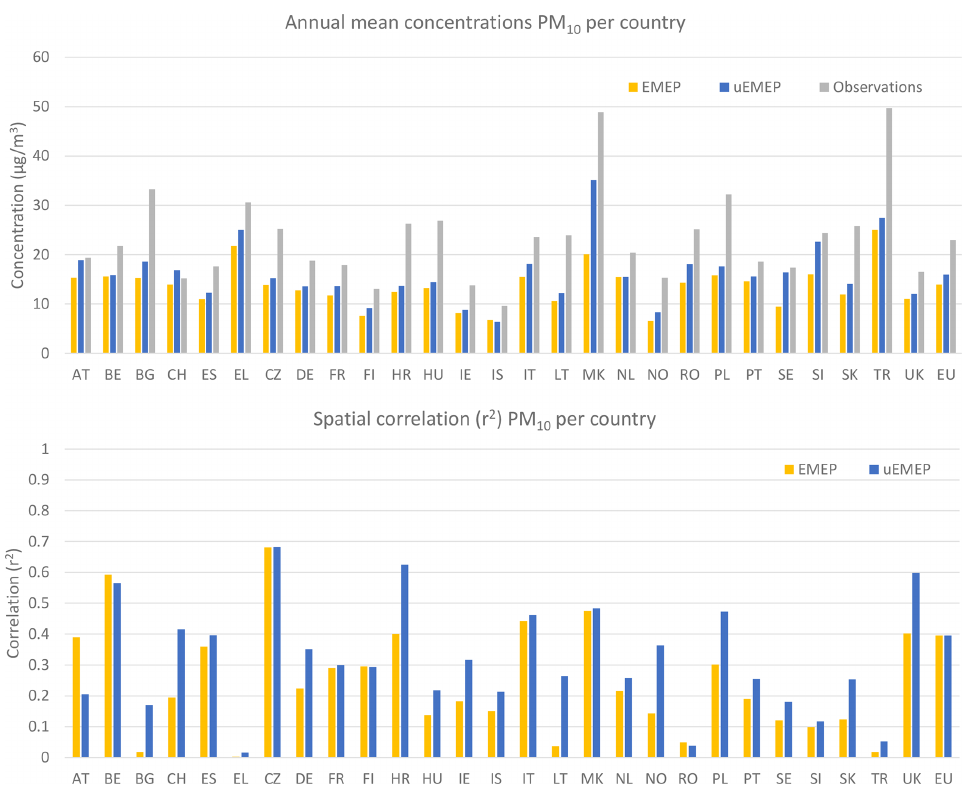
Figure 9. Annual mean PM 10 concentrations and spatial correlation (coefficient of determination r 2 ) per country for 2018 calculated with the EMEP model and uEMEP compared to AIRBASE observations including all types of stations. Only countries with 10 or more stations are shown, but all stations are included in the final EU result. A total of 2891 stations are included in the